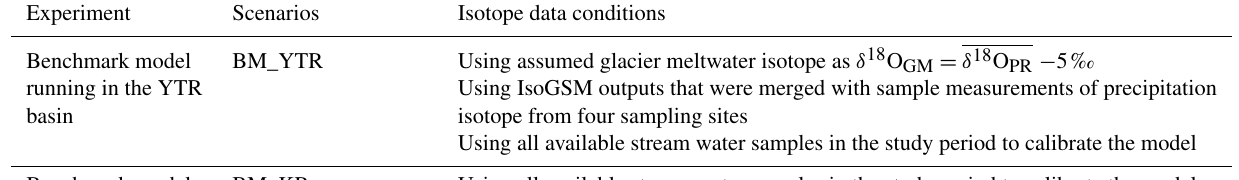
Table 3. Descriptions of water sampling scenarios in the three numerical experiments. δ 18 O GM is the assumed glacier meltwater isotope signature and δ 18 O PR refers to the long-term mean isotope signature of